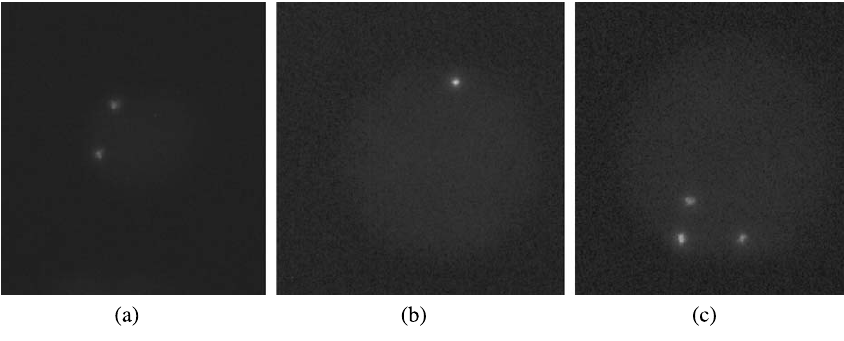
Fig. 2. An example of a normal cell with two chromosomes X (a), two abnormal cells with one chromosome X (b), and three chromosomes X (c) automatically scanned and obtained in green fluorescent spectrum.